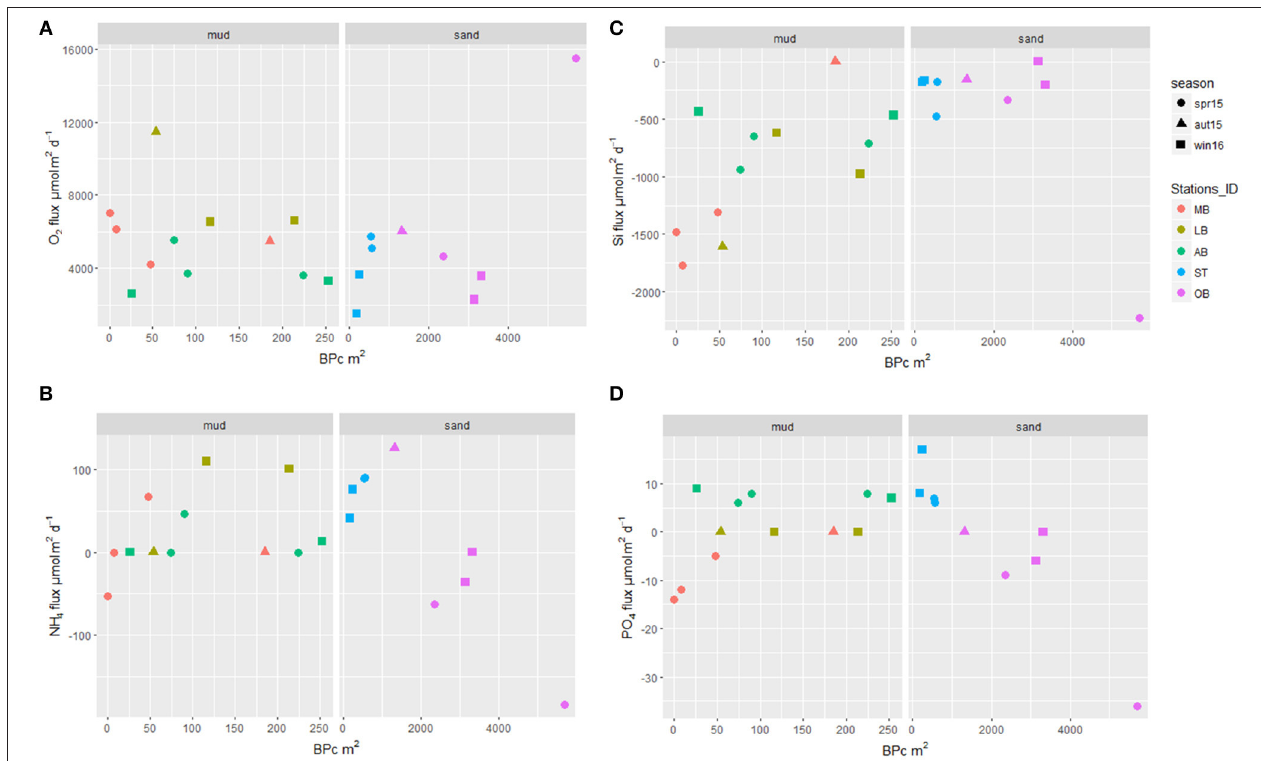
FIGURE 6 | Total oxygen uptake (A) , NH 4 (B) , Si (C) and PO 4 (D) total solute fluxes [ µ mol m 2 /day] across the SWI (negative values indicate release from the sediment) derived from incubation of natural cores (Lipka et al., 2018), plotted against community bioturbation potential BPc. Different colors indicate different stations, different symbols show seasonal